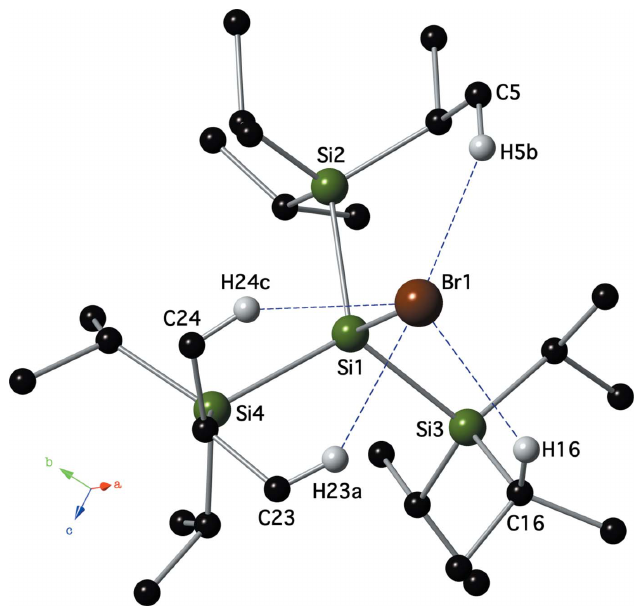
Figure 3 Intramolecular C—H (cid:2)(cid:2)(cid:2) Br hydrogen bonds (blue dashed lines; see Table 2) present in compound II . For clarity, only the hydrogen atoms involved in a hydrogen bonding are